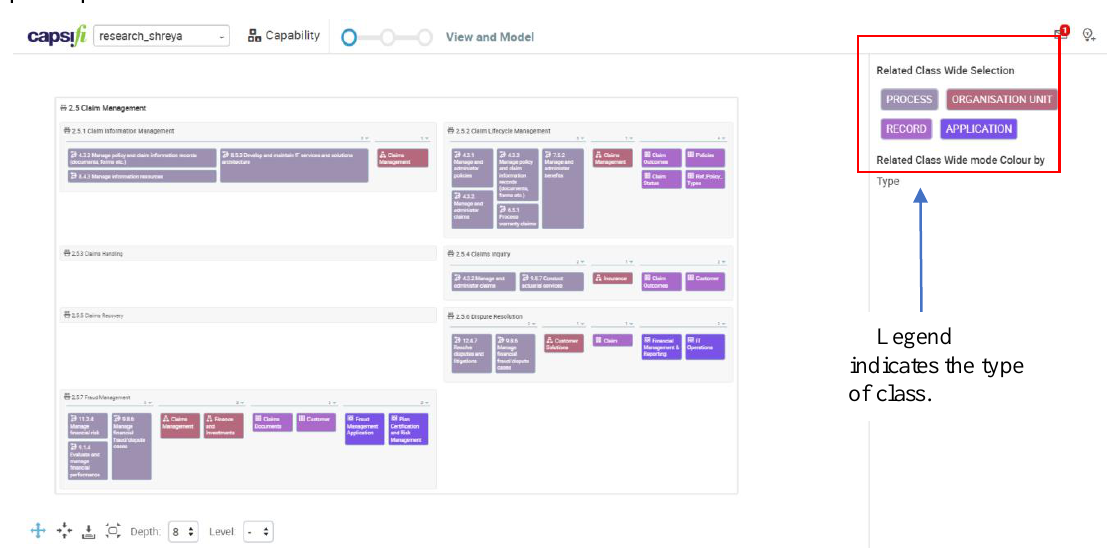
Figure 9. Capability map and the PPIT dimensions